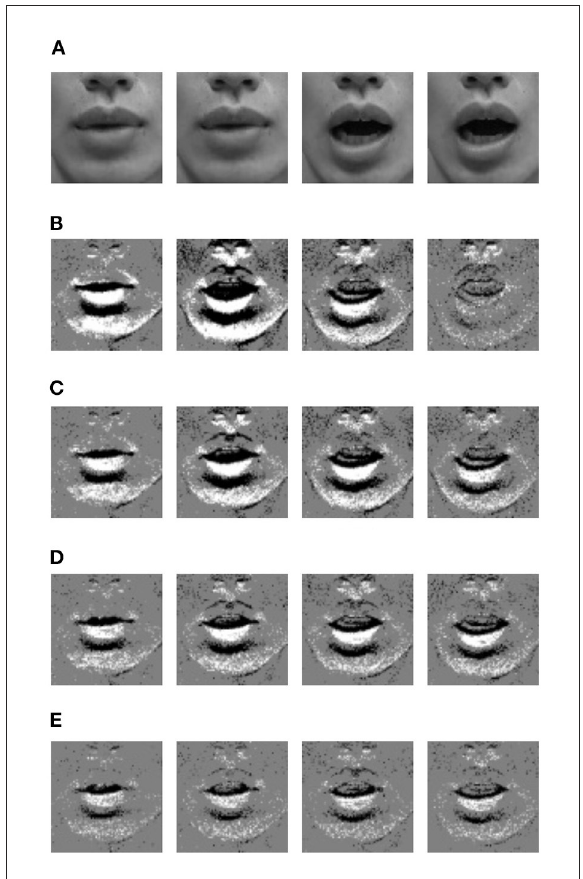
FIGURE3 LipROIs of frame images and event images when uttering sound /A/. (A) Frame image @29.97 fps. (B) Event image @29.97 fps. (C) Event image @60 fps. (D) Event image @100 fps. (E) Event image @200